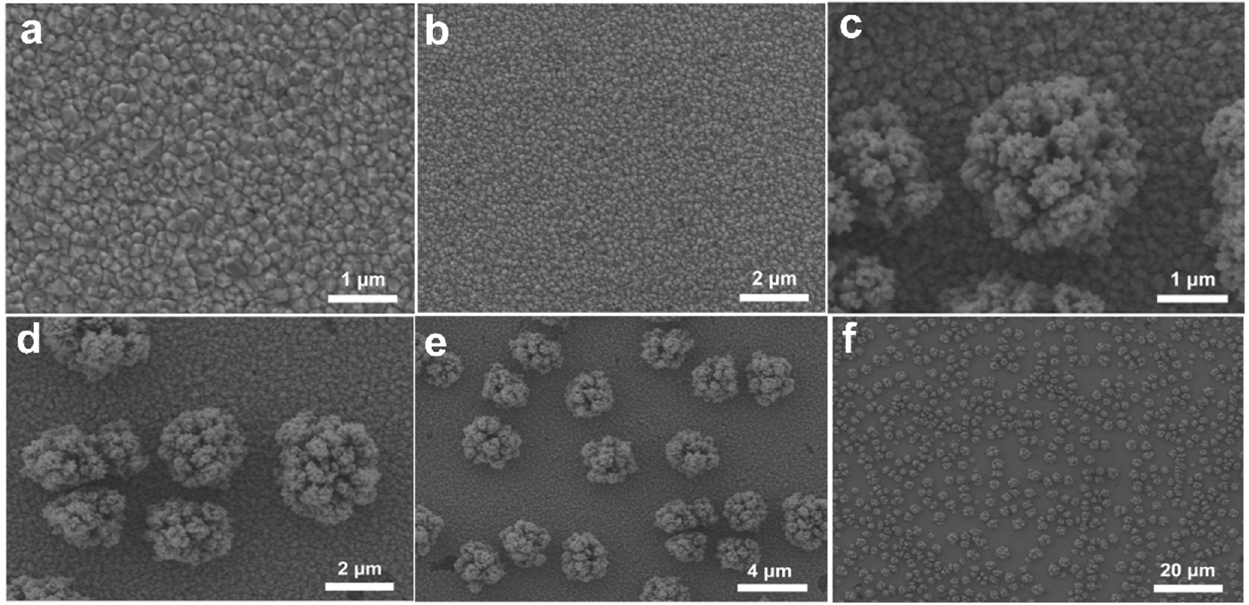
Figure 2. SEM images of the bared FTO with different scale bars: ( a ) 1 μ m, ( b ) 2 μ m. SEM images of Cu 0 with different scale bars: ( c ) 1 μ m, ( d ) 2 μ m, ( e ) 4 μ m, ( f ) 20 μ m.